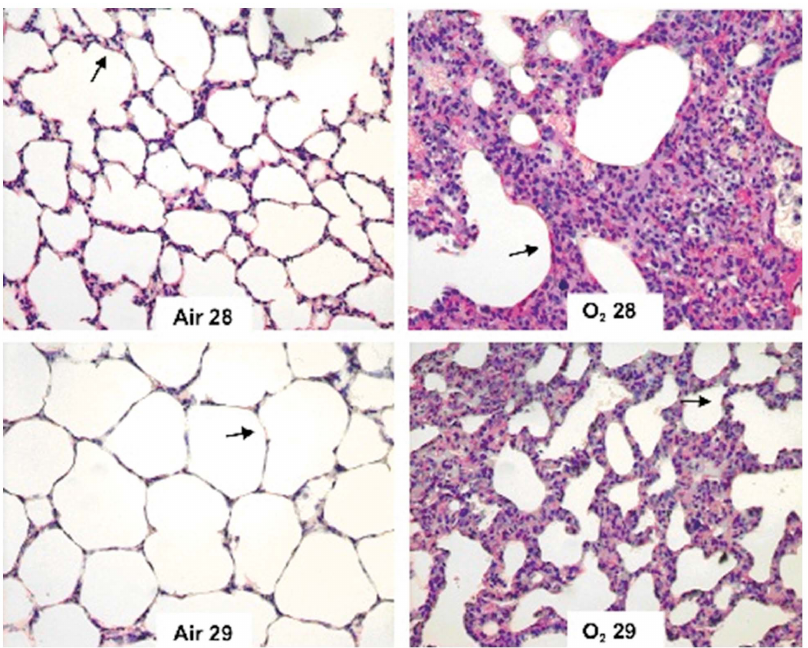
Figure 5. Distribution of collagen fibers (arrows) in the study groups. Animals exposed to oxygen showed an increased proportion of collagen fibers compared to those exposed to room air.